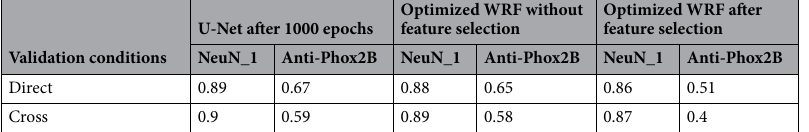
Table 8. Comparison between U-Net and optimized WRF F-Scores with and without feature selection for both staining and